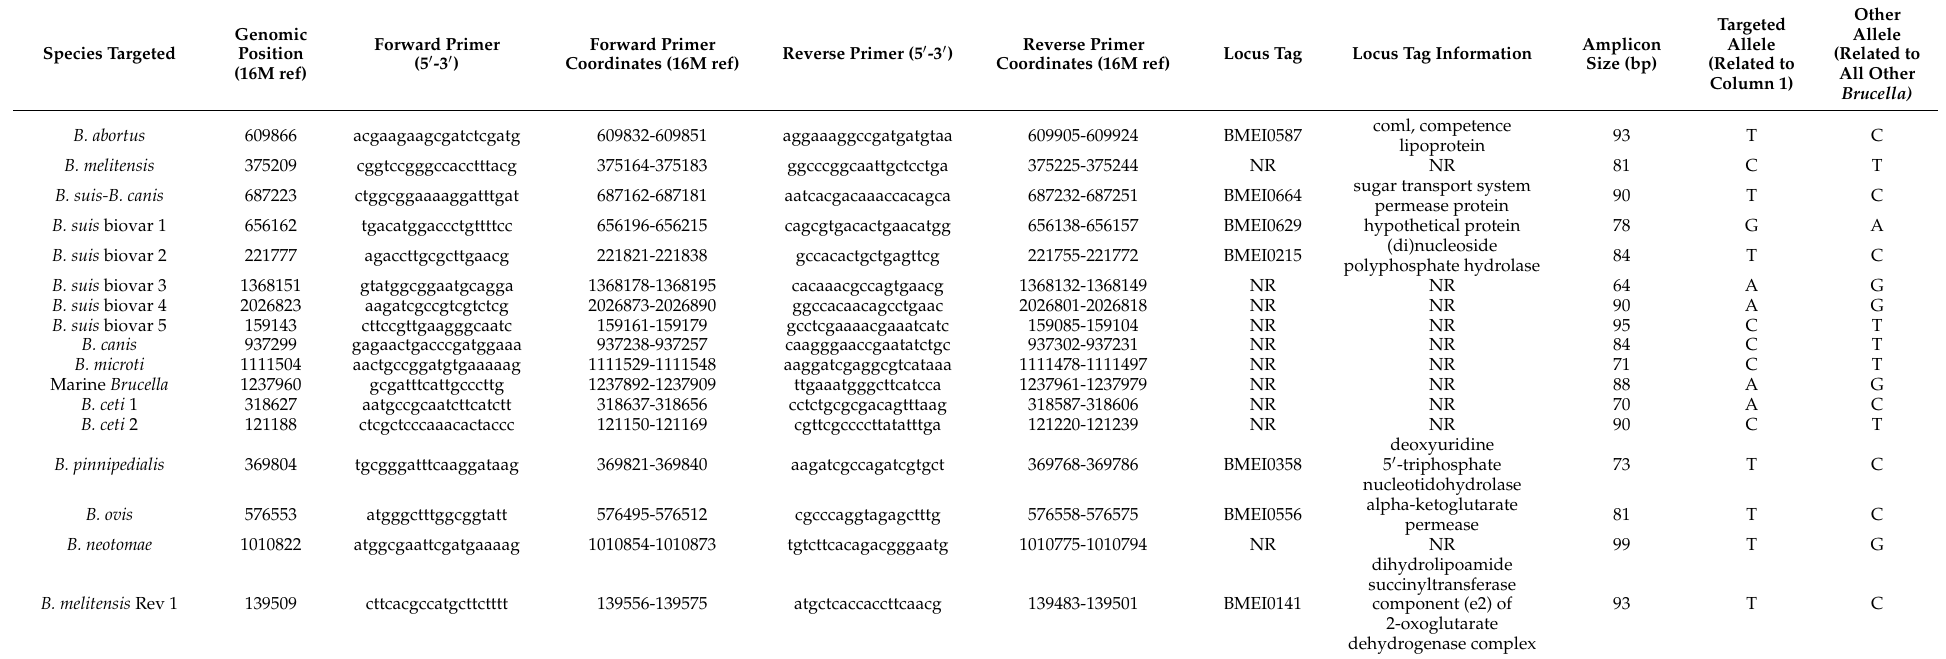
Table 1. SNPs used for HRM-PCR and related